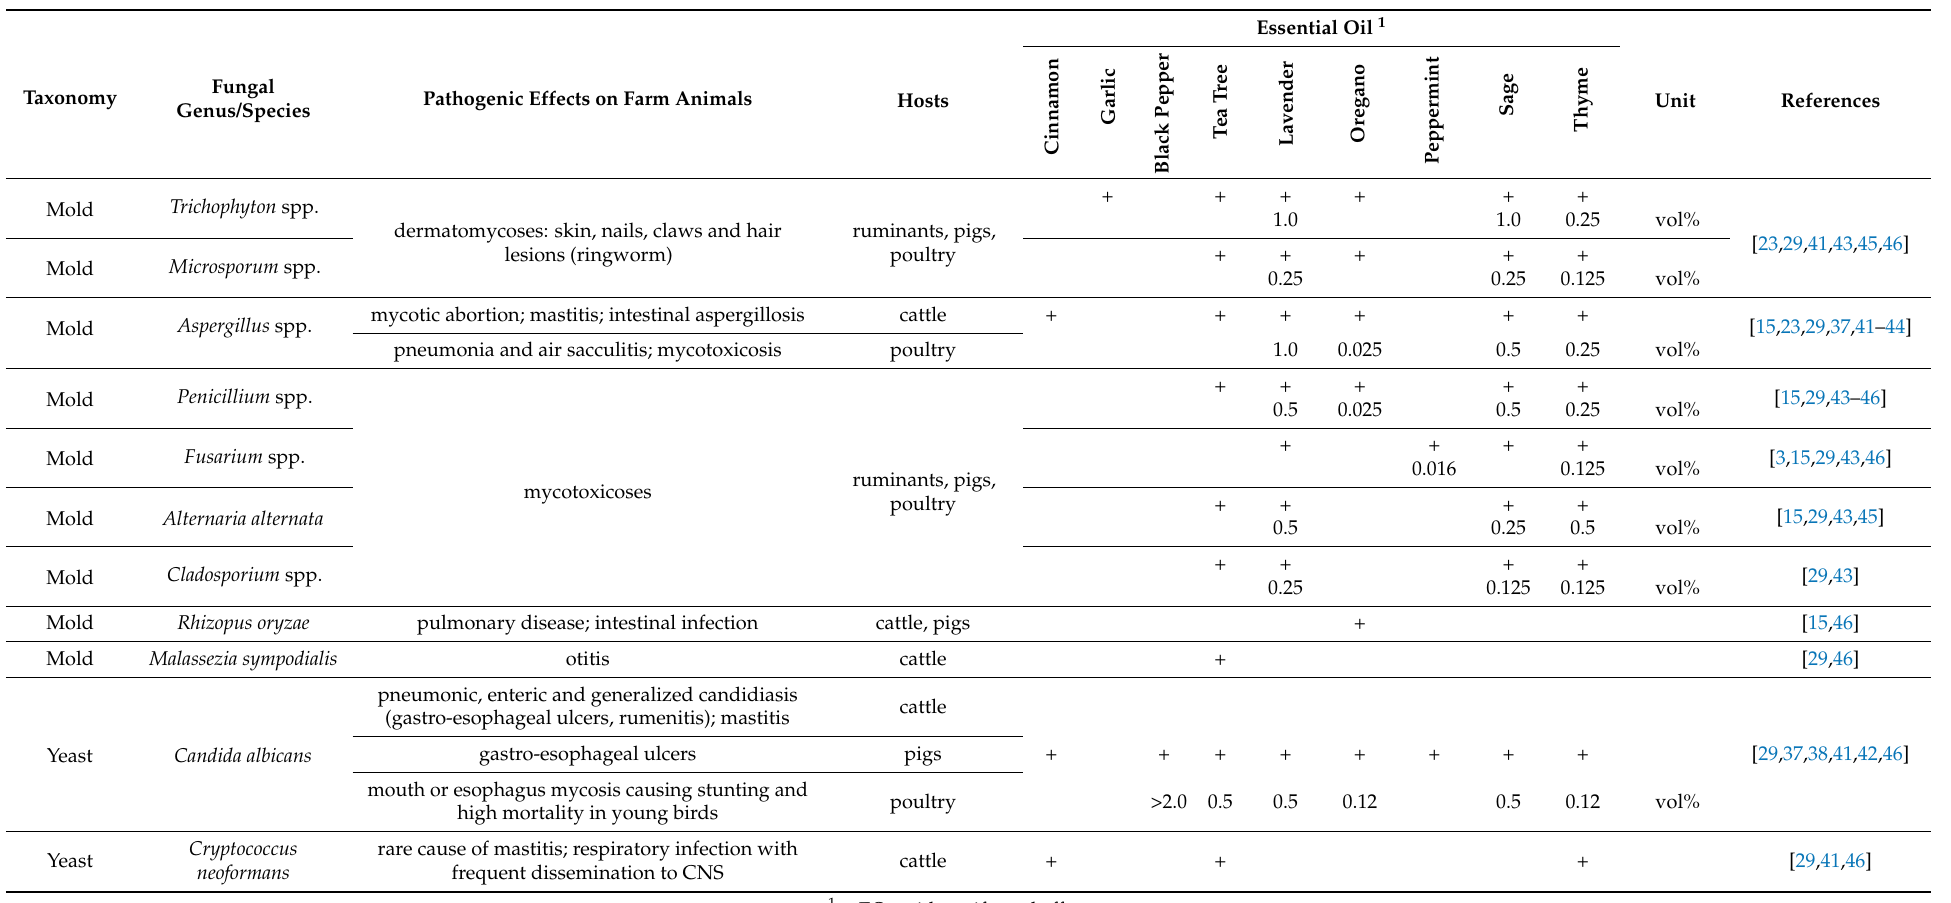
Table 3. Antifungal properties of selected essential oils (EOs) and sensitivity of animal pathogenic fungi to essential oils (minimum inhibitory